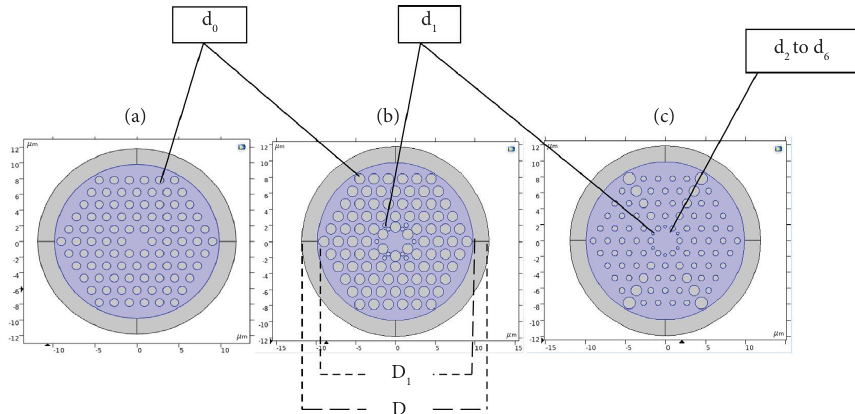
Figure 1: Generalized cross-sectional structure of the PCFs: (a) PCF with uniform air holes and without tiny air holes, (b) PCF with uniform air holes and insertion of 10 tiny air holes in the frst ring, and (c) PCF with nonuniform air holes and inclusion of 6 tiny air holes in the frst